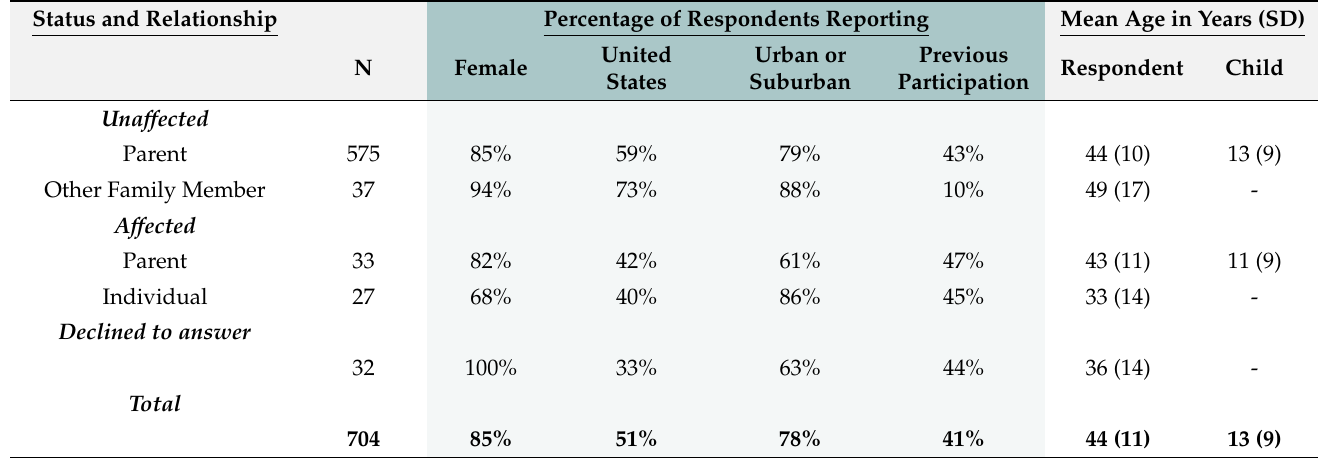
Table 1. Participant Demographics.